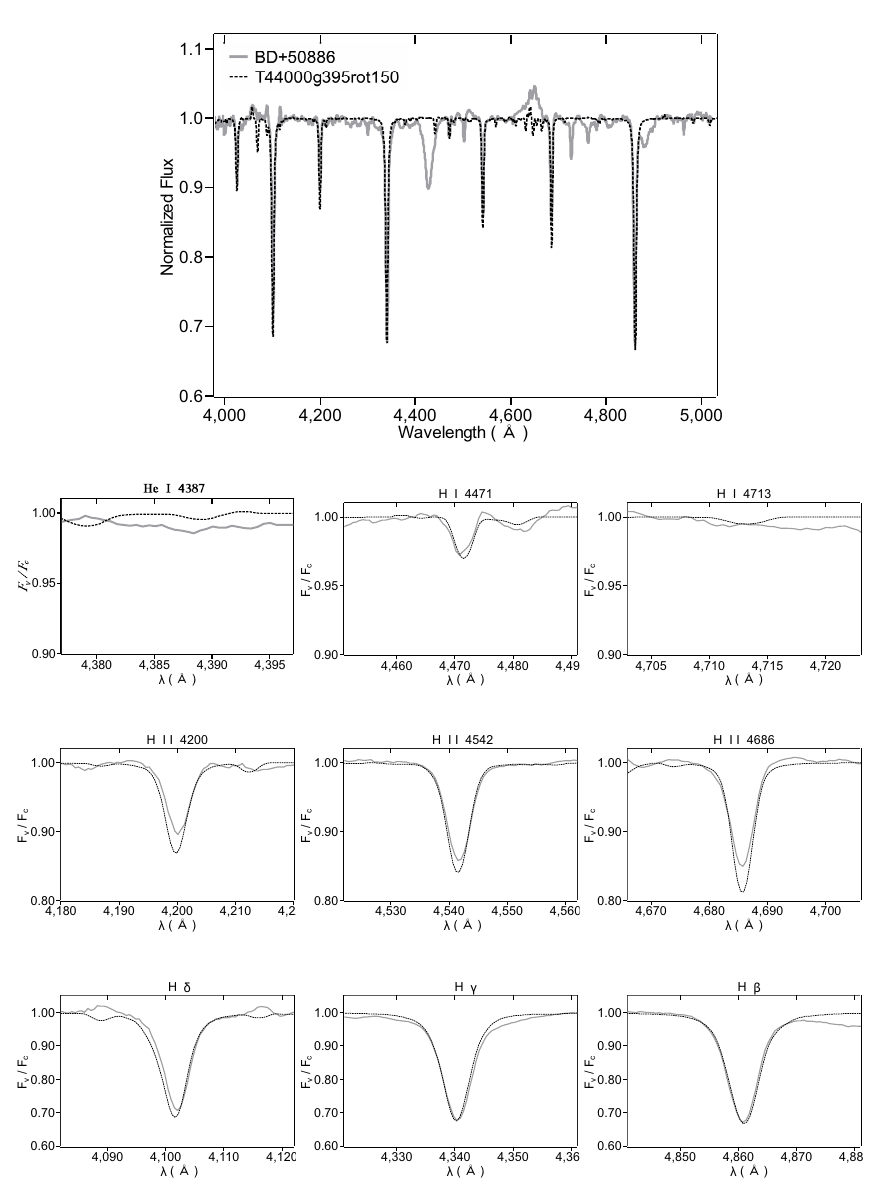
Fig. 2 Best fit (black dotted line) of the observed (gray line) of BD+50886.The upper figure shows the whole fit to the blue-violet spectrum, The lower figure shows detailed fits for the standard diagnostic lines of He and H . The effective temperature is 44000 K, log g = 3 . 95 and vsini =150 km s − 1